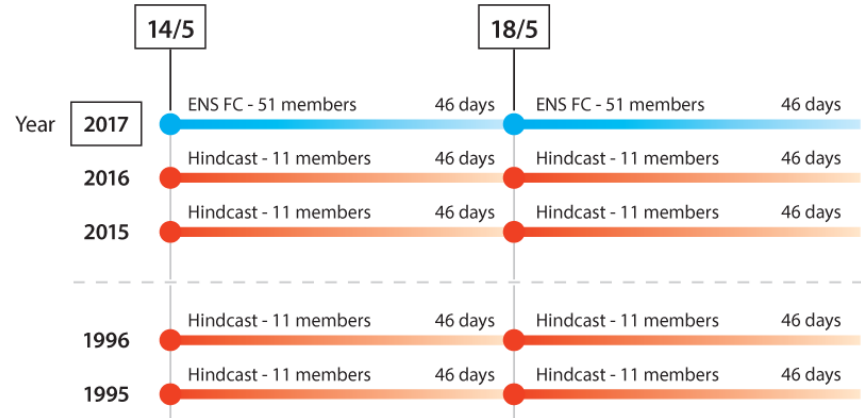
Figure 1. Schematic overview of the operational ECMWF ensemble forecast for the extended range and its associated hindcast. The hindcasts consists of a reduced ensemble forecast (11 members) with the same starting date of year as the current forecast, but run for the previous 20 years.